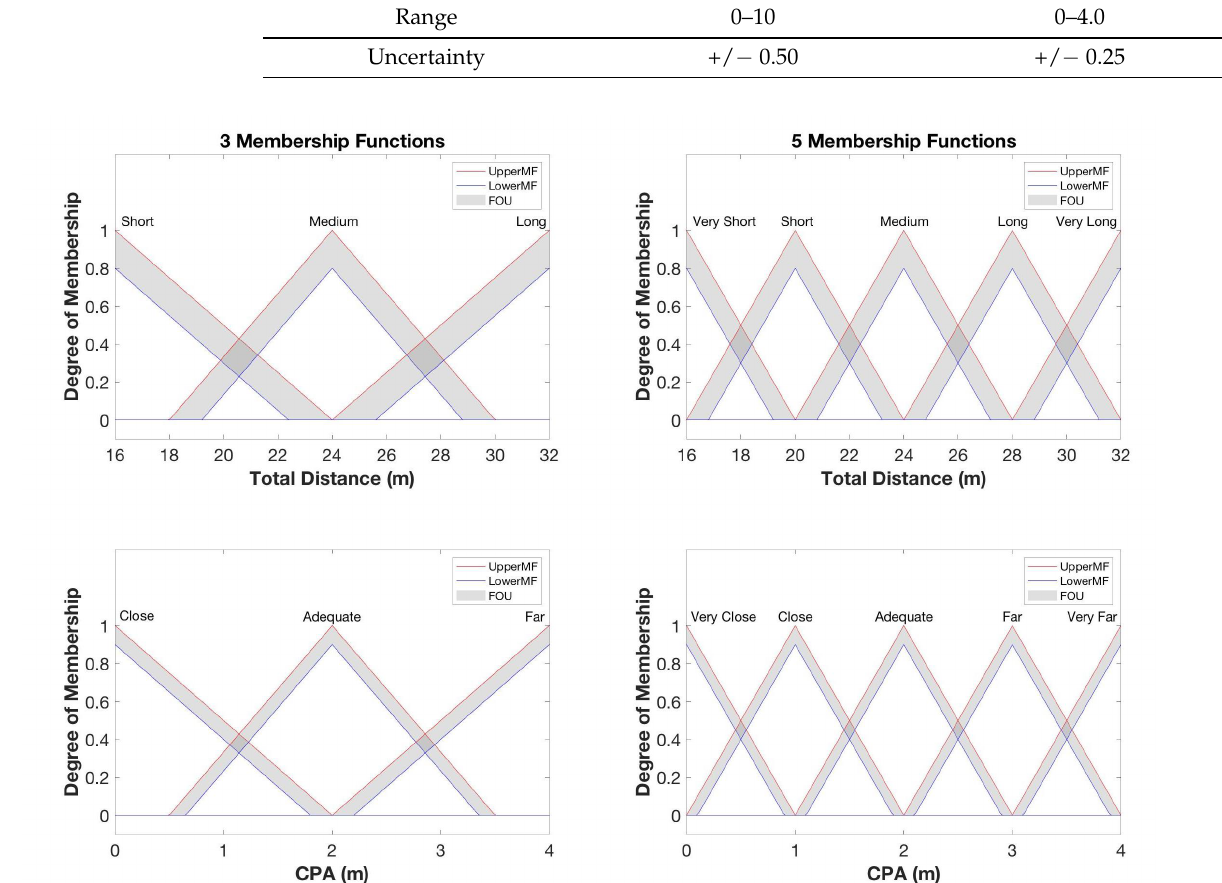
Figure 11. Membership functions for total distance and